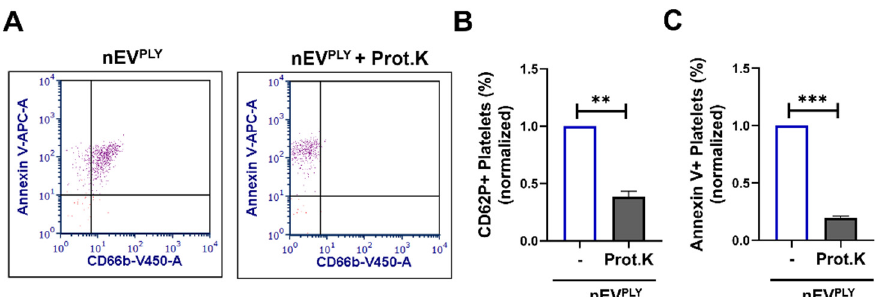
Figure 7. Neutrophil extracellular vesicle (nEV) surface proteins mediate platelet activation. Human platelets were stimulated with nEVs (pre-treated with proteinase K or not) from PLY-stimulated neutrophils (nEV PLY ). nEVs and platelets were analyzed by flow cytometry. ( A ) Staining of nEV PLY with CD66b (Pacific Blue) and annexin V (APC) shows that proteinase K treatment effectively removes proteins from EVs but not lipids (annexin V binds to PS). Representative dot plots are depicted. Percentage of ( B ) CD62P positive or ( C ) annexin V positive platelets treated with nEV PLY (proteinase K pre-treated or not). n = 3. ** p < 0.01, *** p < 0.001, Welch’s t -test.